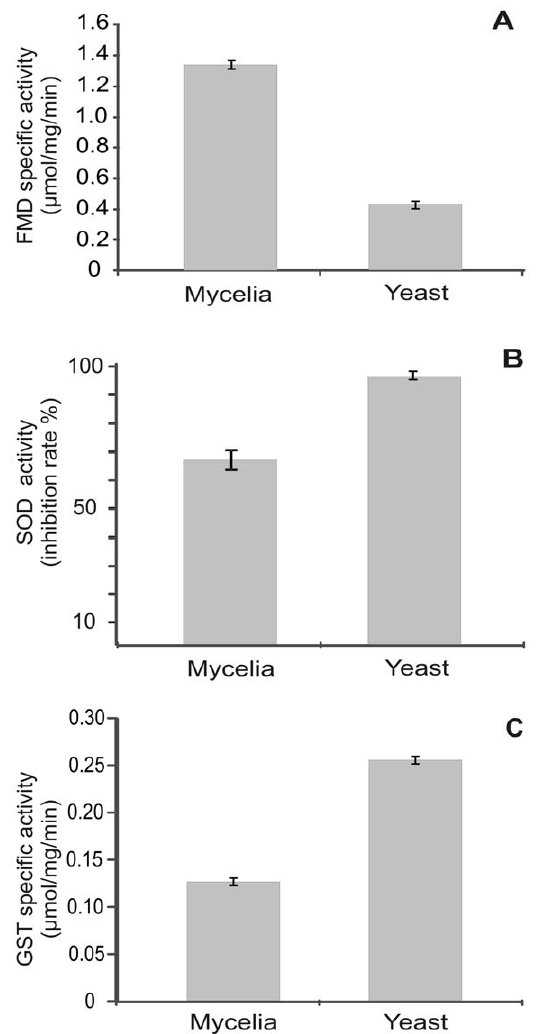
Figure 4. Enzymatic activity analysis validates the secretome data for Paracoccidioides mycelia and yeast cells. Activity assay results of ( A ) formamidase (FMD), ( B ) superoxide dismutase (SOD) and ( C ) glutathione S-transferase (GST) assessed for mycelia and yeast protein extracts. FMD activity was assessed by measuring the levels of ammonia released using a standard curve. The SOD and GST Assay Kit were used to determine SOD and GST enzymatic activity, respectively. The student’s t test was used for statistical comparisons, and the observed differences were statistically significants ( p # 0.05). The erros bars represent the standard deviation of three biological replicates. harbor serine/tyrosine phosphorylation and/or lysine acetylation sites. Eight of the nine isoforms of 2-methylcitate synthase were found to be phosphorylated, which correlates with the decrease in pI . We also identified 30 acetylated proteins out of 116 isoforms, and all isoforms of the hsp70-like proteins harbored at least five acetylated peptides. The pI shifts in those molecules correlates with those observed in proteins derived from breast cancer cell lines, in which the pI shifts were consistent with the number and type of modifications [59]. The PTM may be associated with novel functions of intracellular proteins located outside of the fungal cells.